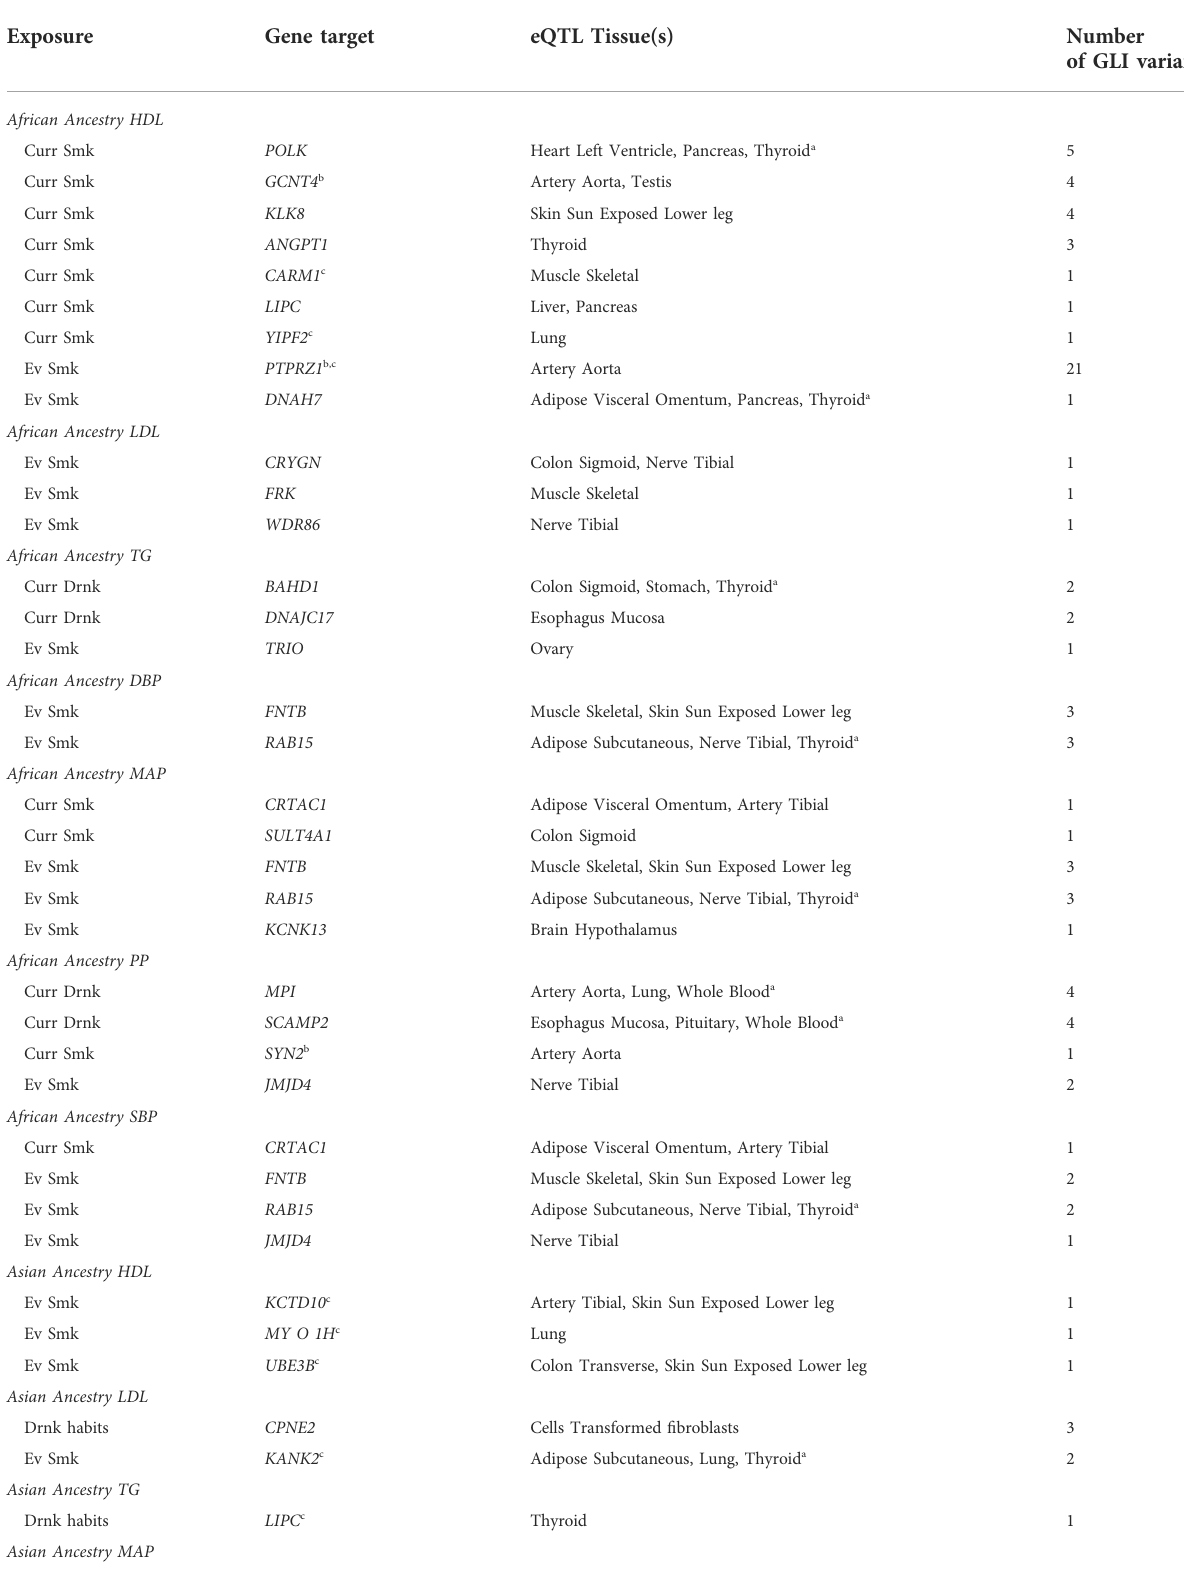
TABLE 2 Prioritized